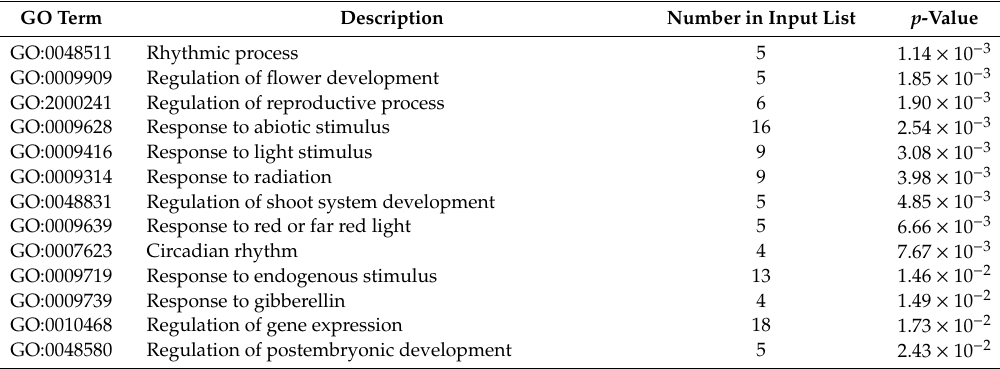
Table 1. List of GO terms of genes upregulated more than 2-fold in HRE1α OXs.